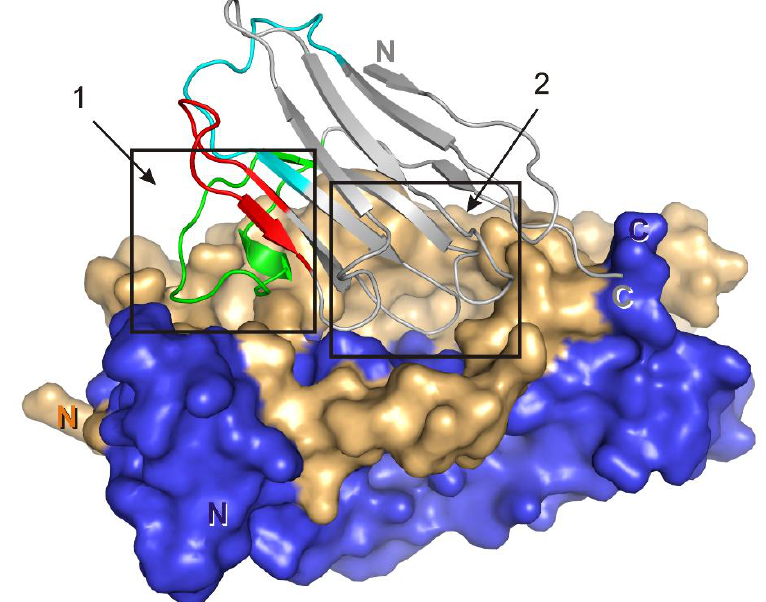
Figure 7. V H H/IL-17A complex. Surface of the IL-17A dimer is shown (monomer A is dark blue, monomer B is yellow). Crystallographic model of the V H H domain is in gray. CDR-H1–cyan, CDR-H2–red, CDR-H3–green. The two contacting regions are indicated by frames.